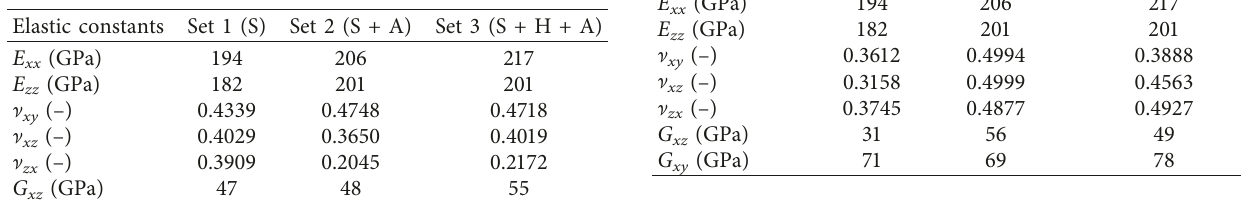
Table 9: Elastic constants from DIC, for a transversely isotropic material model. This model is referred to as “DIC method” in figures below.